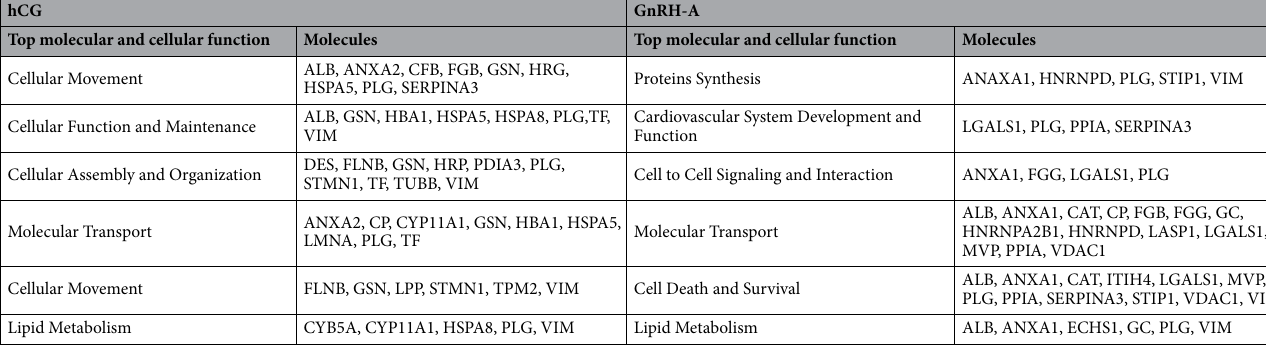
Table 1. Functional analysis of differentially abundant proteins in follicular walls of prepubertal and mature gilts treated with either hCG or